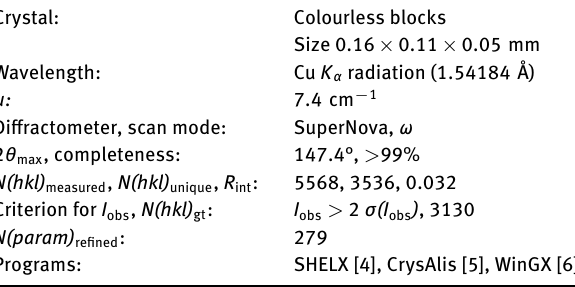
Table 1: Data collection and handling.